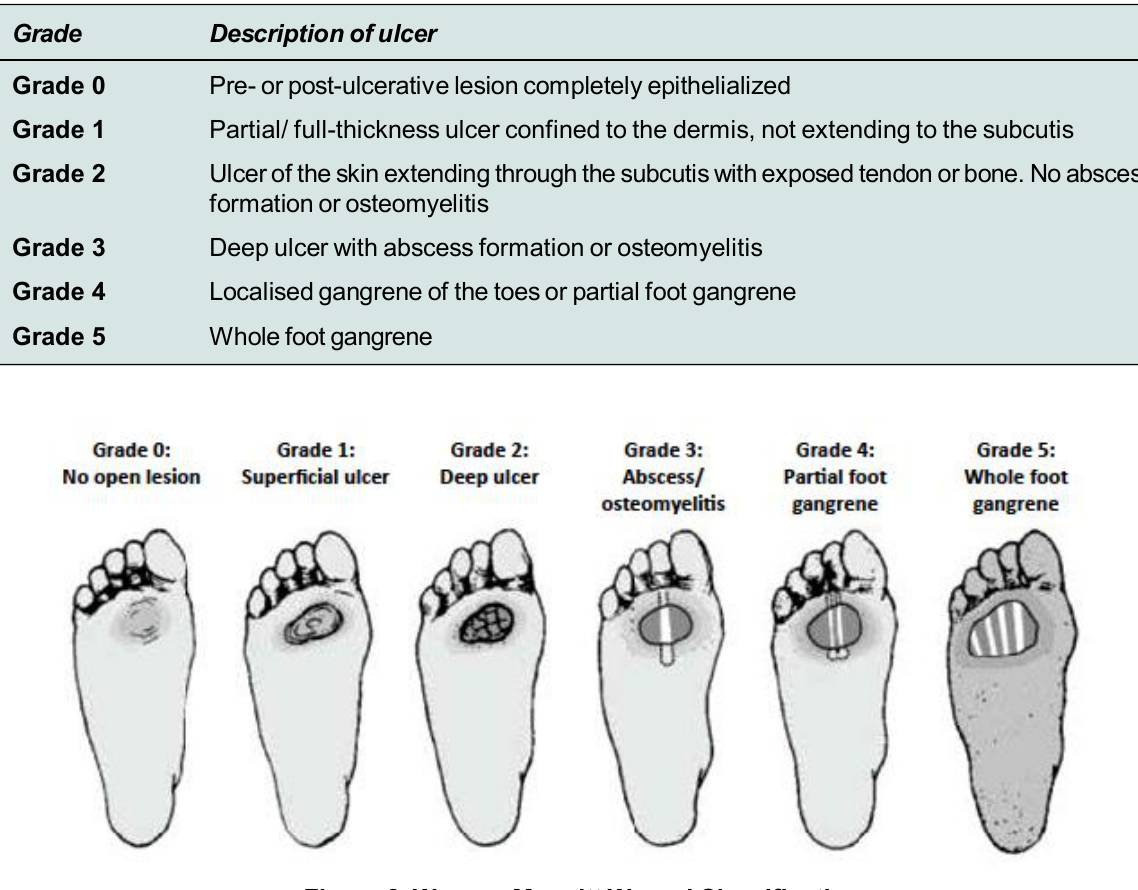
Figure 2. Wagner-Meggitt Wound